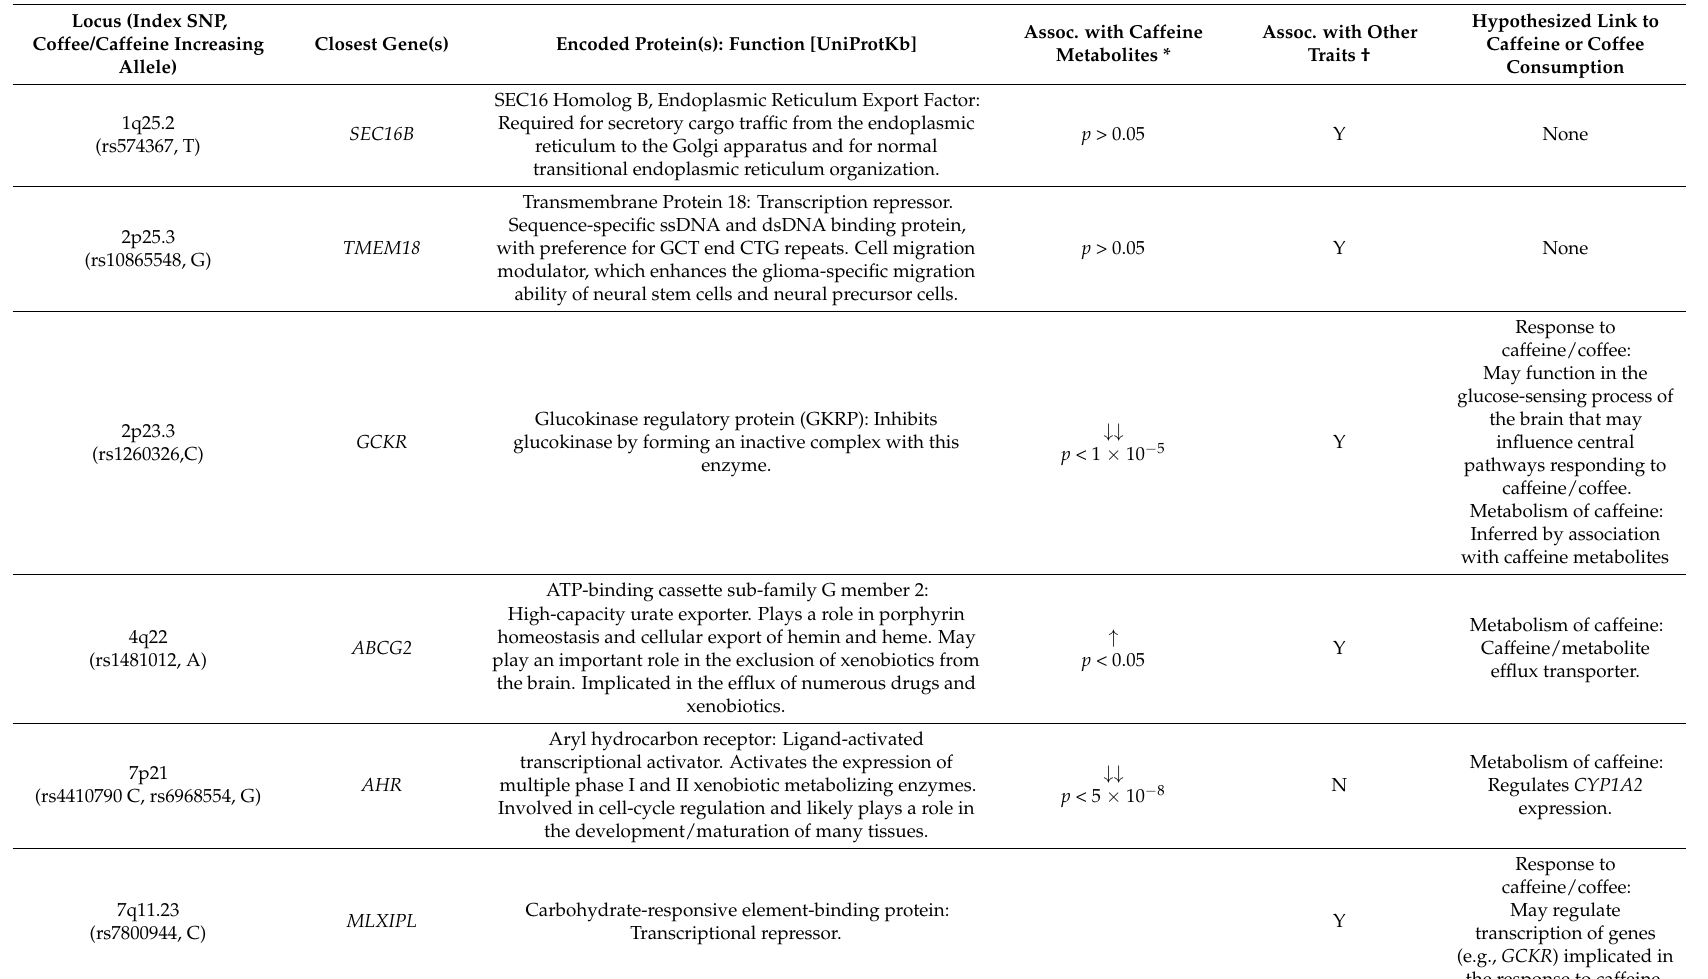
Table 1. Genetic determinants of coffee and caffeine consumption